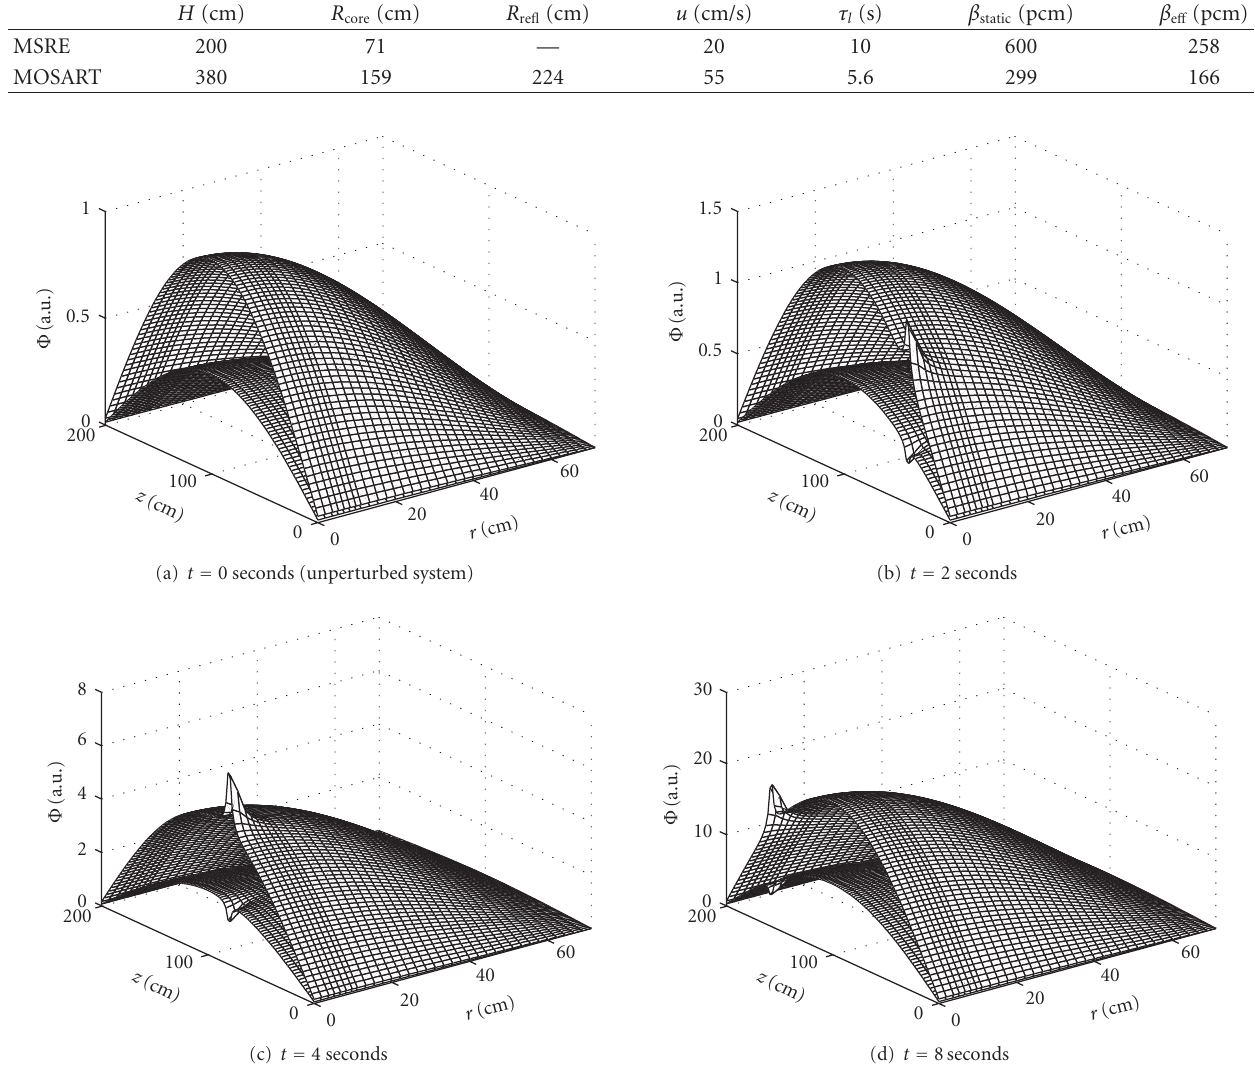
Figure 1: Behavior of the neutronic flux during the transit of the fissile lump. Two energy groups are considered (higher-level flux corre- sponds to the first group) and the solution is plotted at di ff erent instants during the circulation